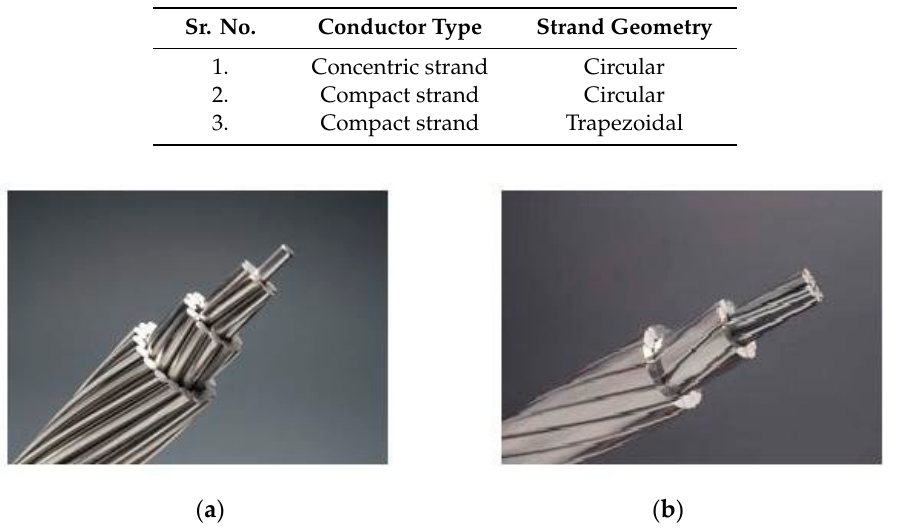
Table 1. Stranded conductors used in conventional power transmission systems.